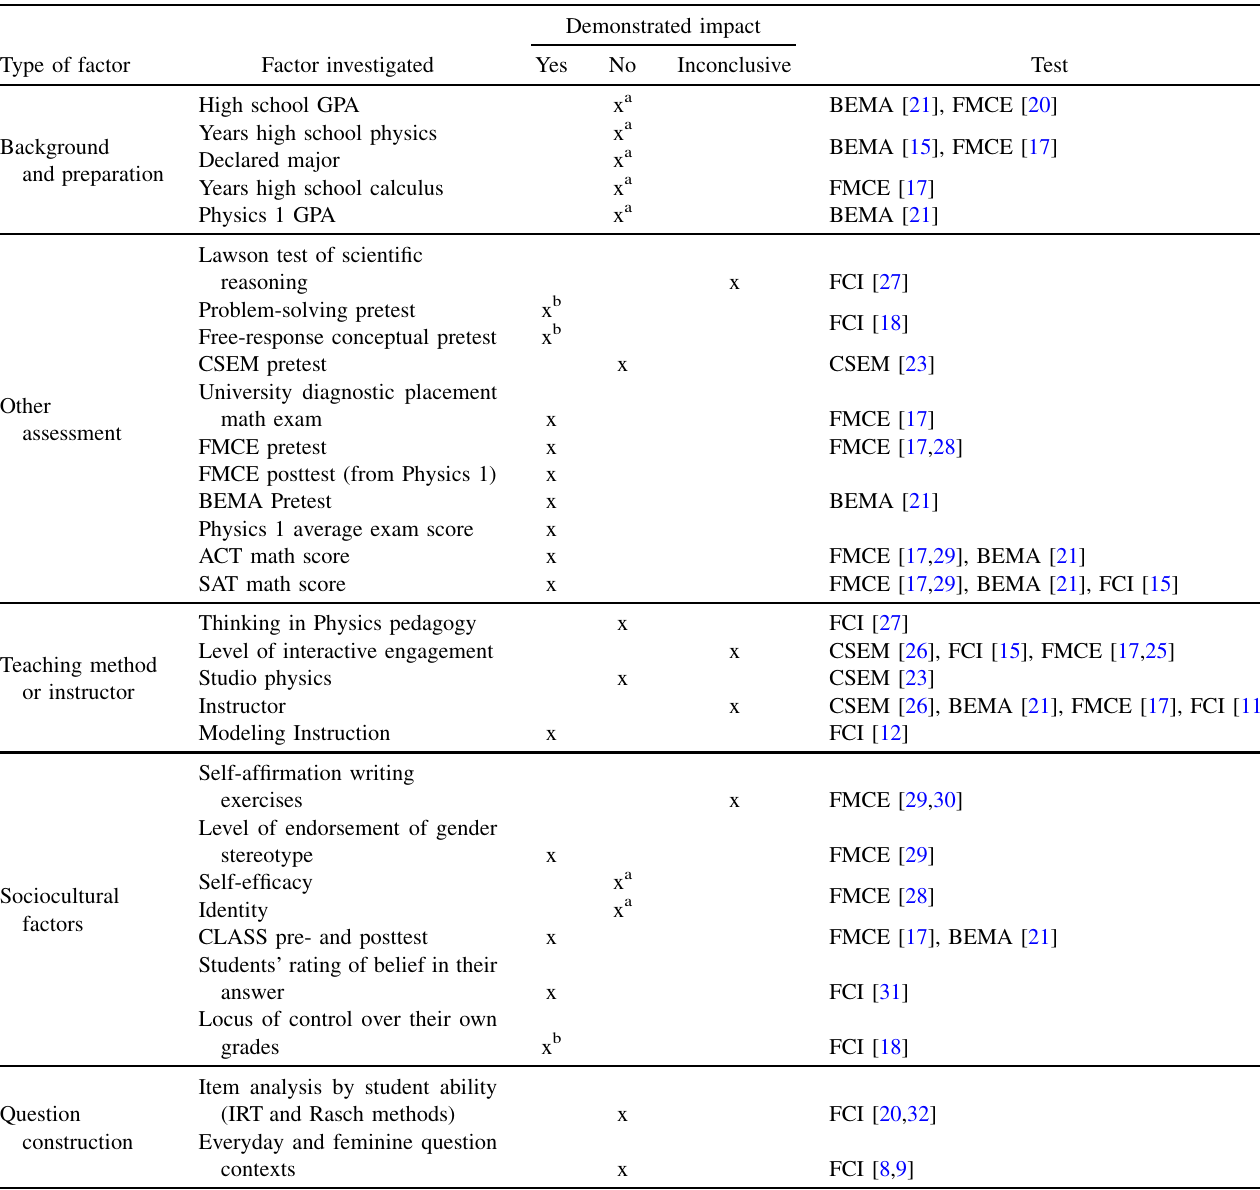
TABLE I. List of factors investigated that may influence the gender gap in pre- and/or posttest scores and the associated concept inventory